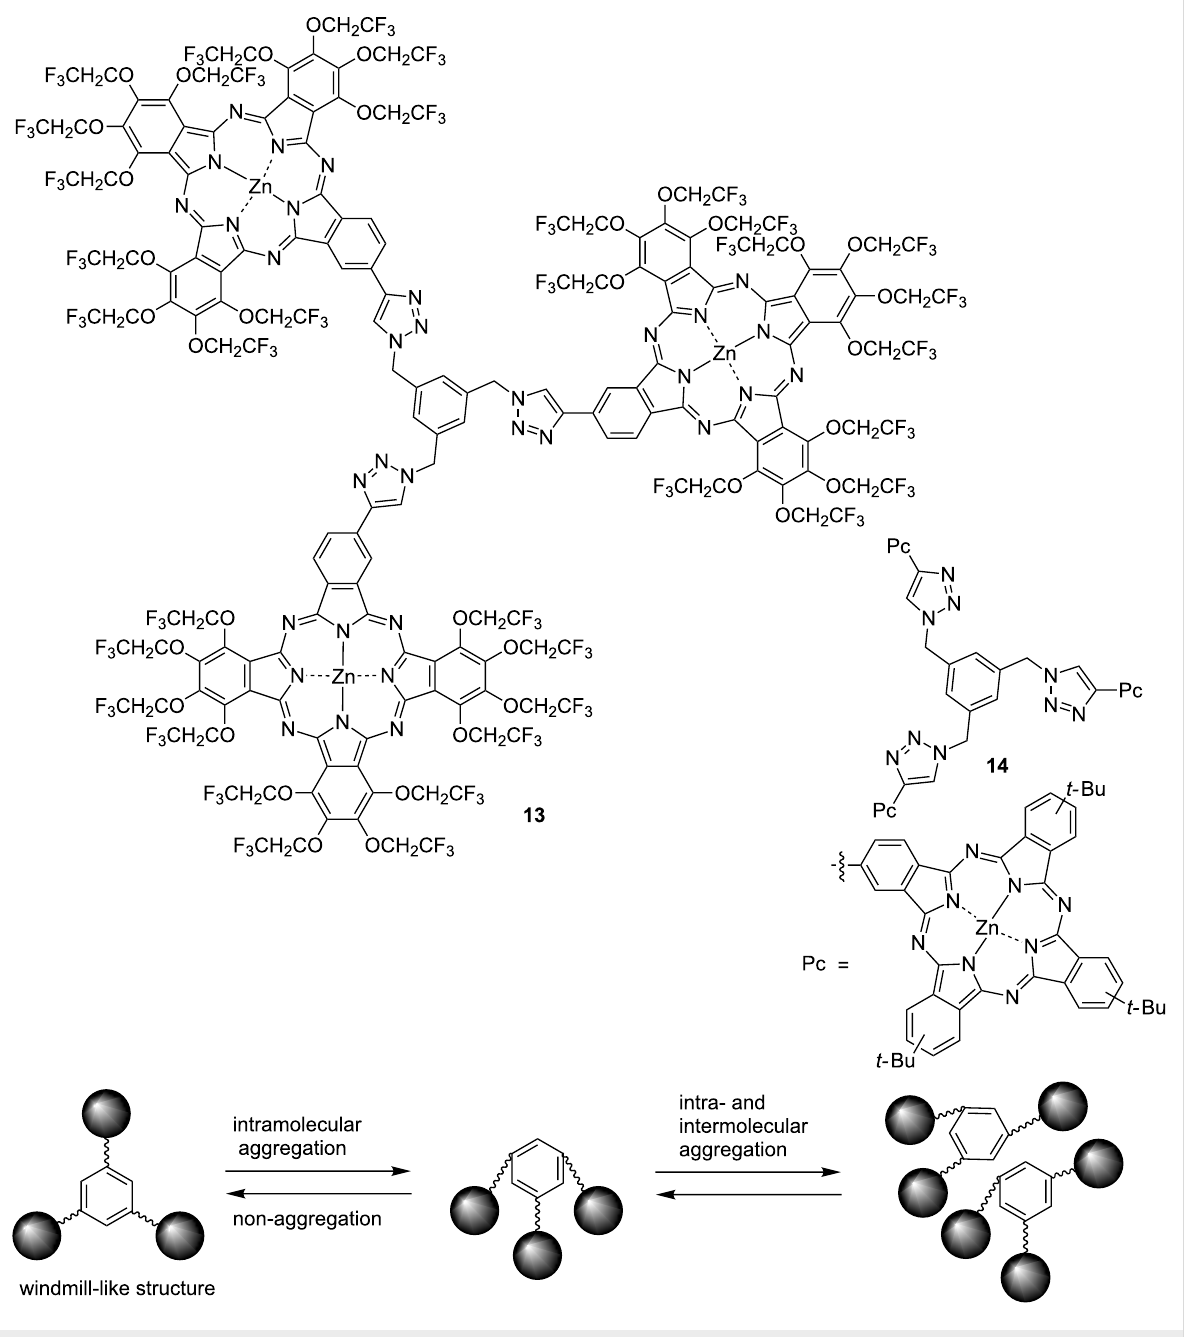
Figure 5: Structure of trinuclear phthalocyanines linked by a triazole linker, and windmill-like molecular structure vs aggregated